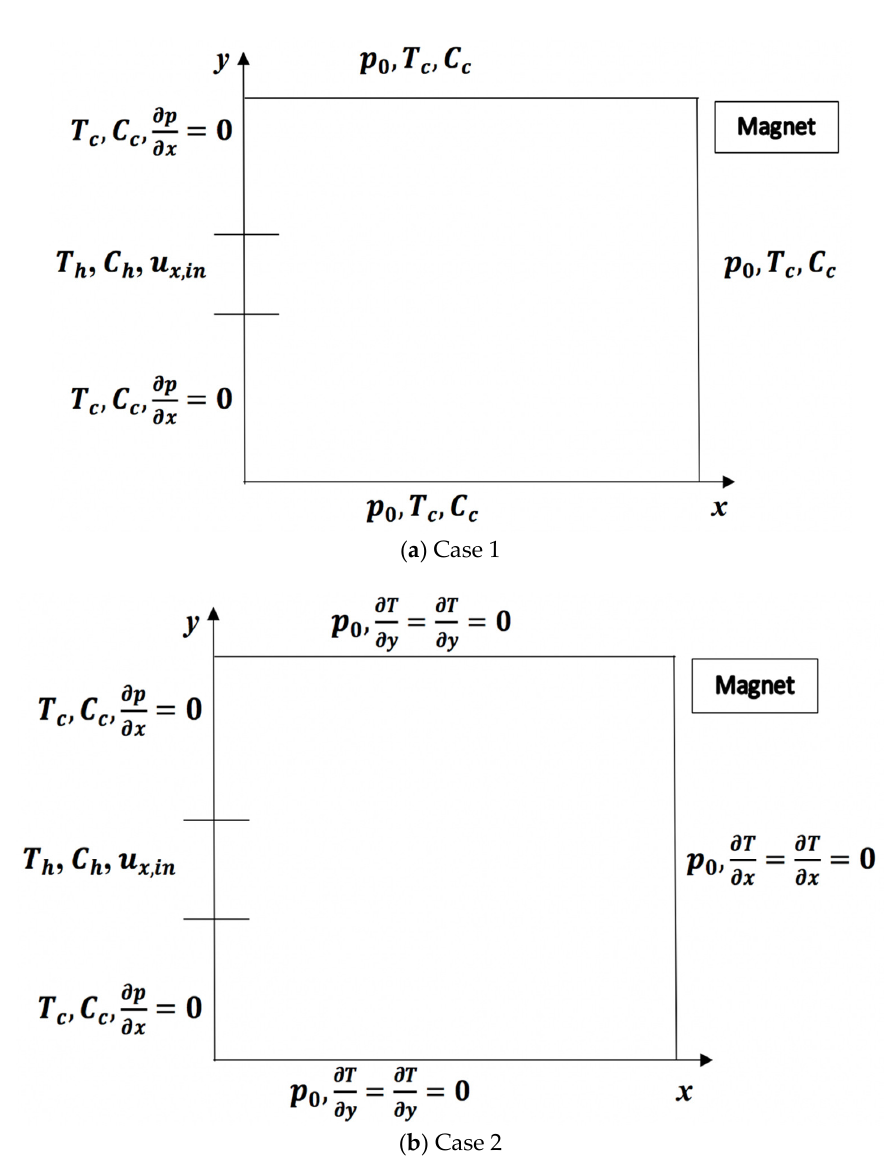
Figure 1. Schematic diagram of the 2D square porous cavity—( a ) Case 1: cavity walls are kept at a low temperature/concentration except the inlet at center of the left wall is kept at a higher temperature/concentration (Dirichlet boundary condition) and inlet velocity (Neumann boundary condition); ( b ) Case 2: the cavity walls are adiabatic and isothermal with constant pressure (Dirichlet boundary condition), except that the inlet at center of the left wall is kept at a high temperature/concentration and the upper/lower of left wall is kept at a low temperature/concentration with no-flow Neumann boundary condition. The z-axis of the local magnet coordinate system is set perpendicular to the poles, the x - y plane.